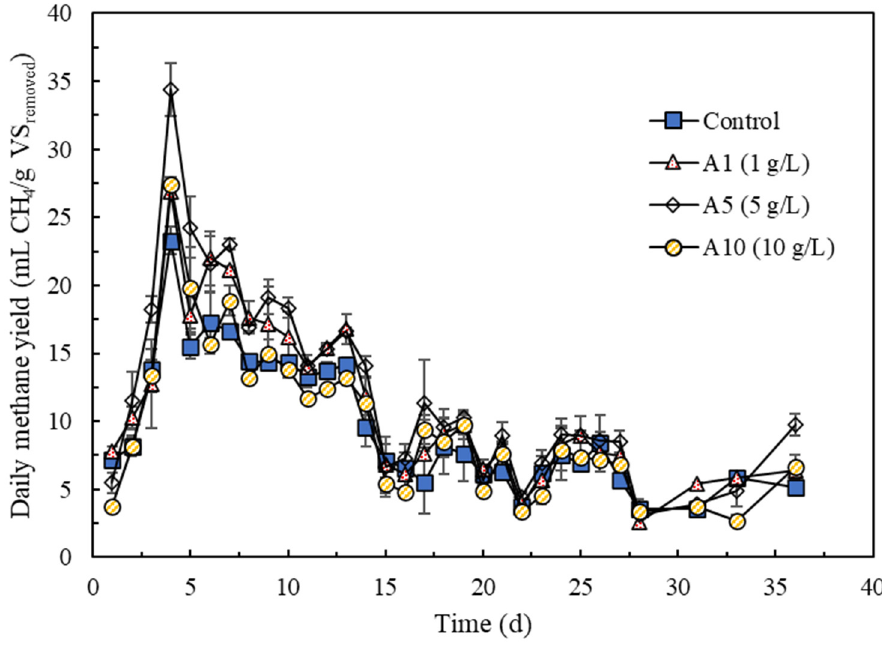
Figure 2. Daily methane yield from AD of dairy manure with the addition of different concentra- tions of